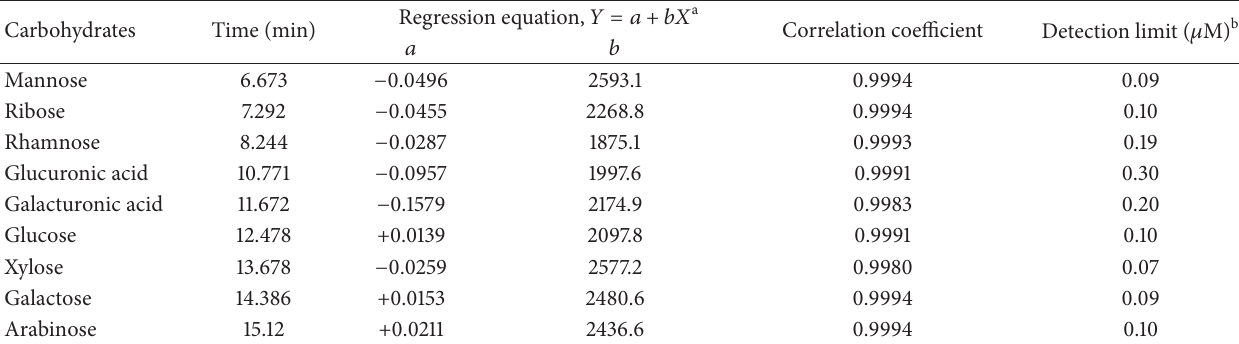
Table 1: Retention time, regression analysis, and LOD for the pre-column PMP derivatization HPLC method. Carbohydrates Time